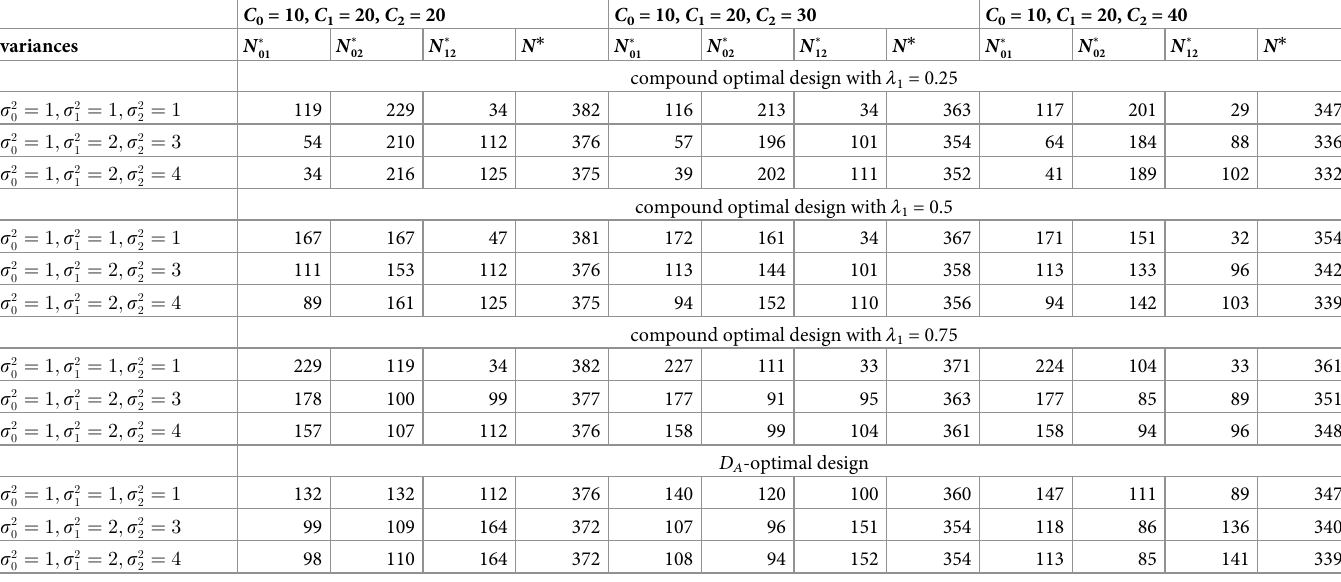
Table 2. Optimal sample sizes for the incomplete within–subject design with scenario 2.